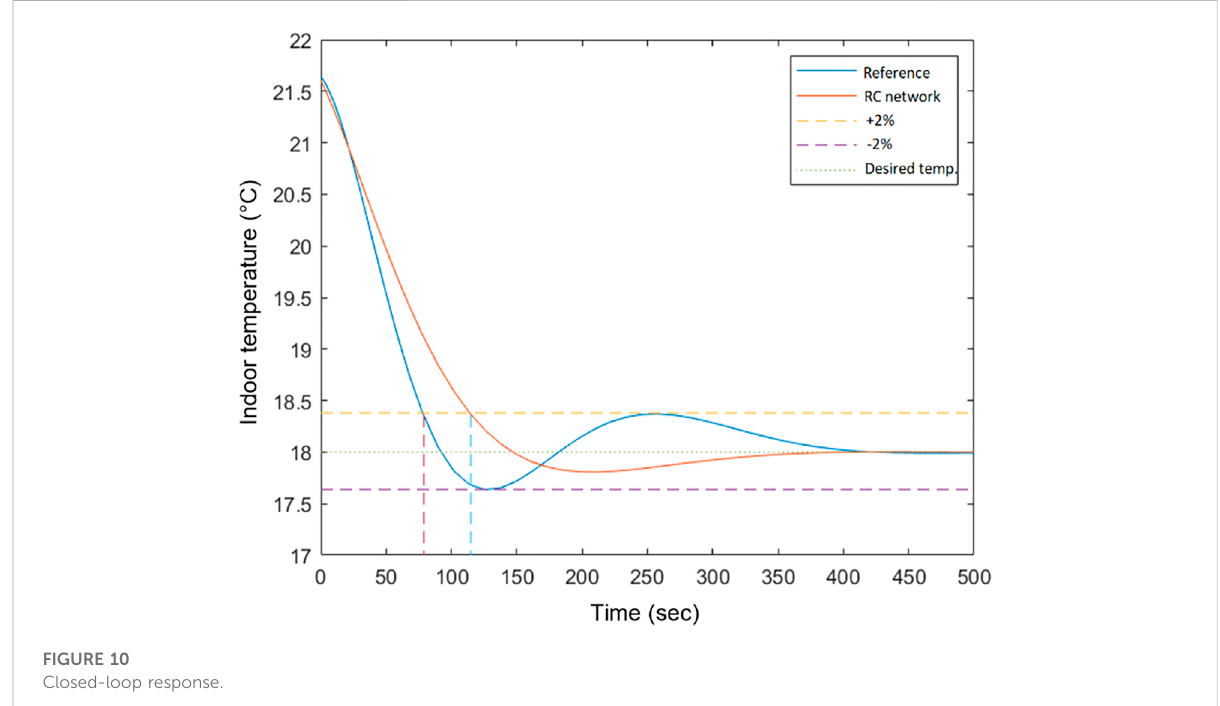
FIGURE 10 Closed-loop response.